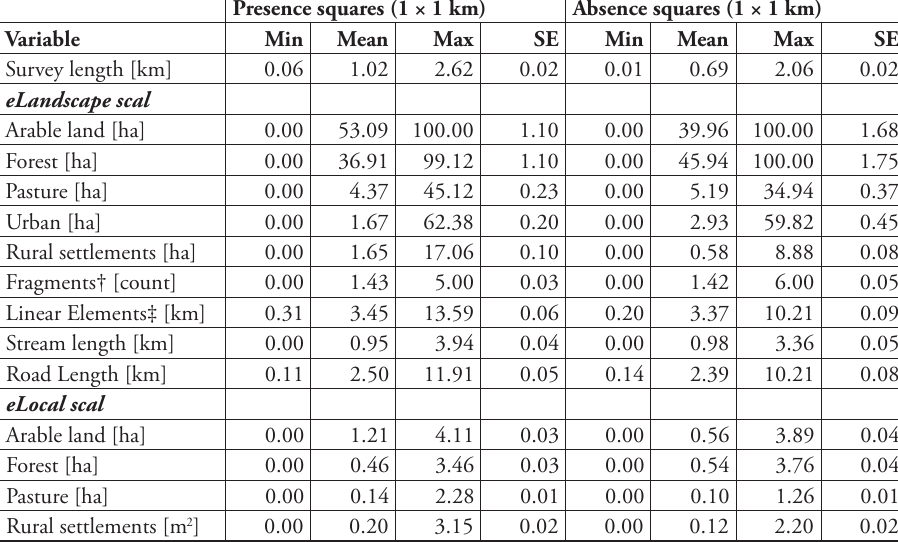
table 1. Descriptive statistics for the major landscape features and predictor variables used in the regres- sion analyses to explain the distribution of Metrioptera roeselii in south-central Sweden